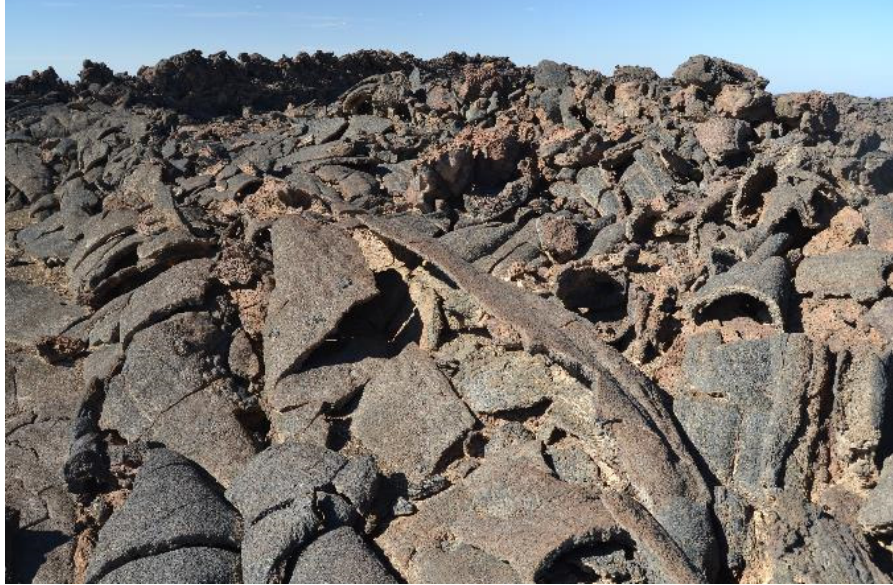
Figure 12. Thin, highly vesicular lava crusts in proximal settings forming a complex collapsed roof zone of ponded lava. Individual lava crust plates are about a meter across.